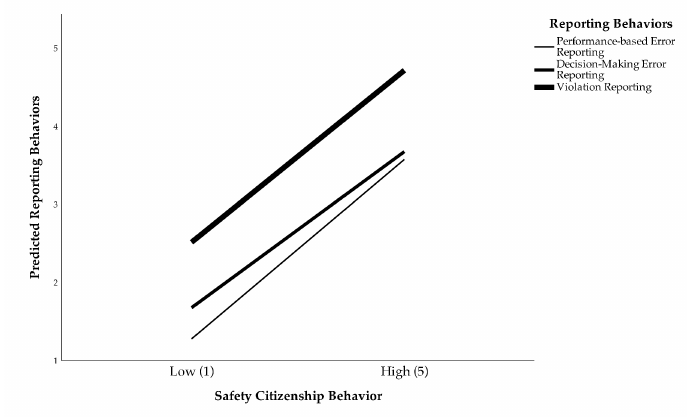
Figure 4. Regression slopes for SCB predicting reporting